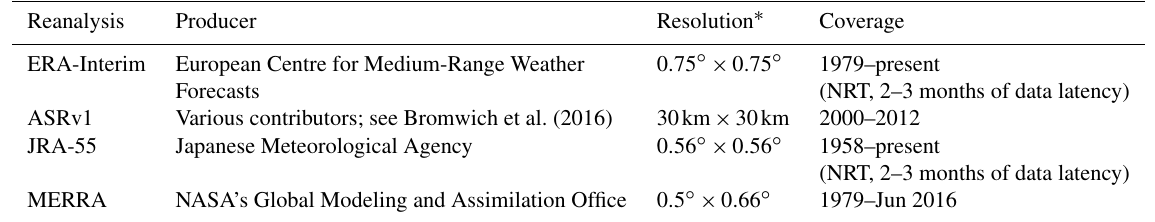
Table 2. Summary of the four different reanalysis datasets used in this study (data availability often subject to change/updates; information is given at the date of submission).